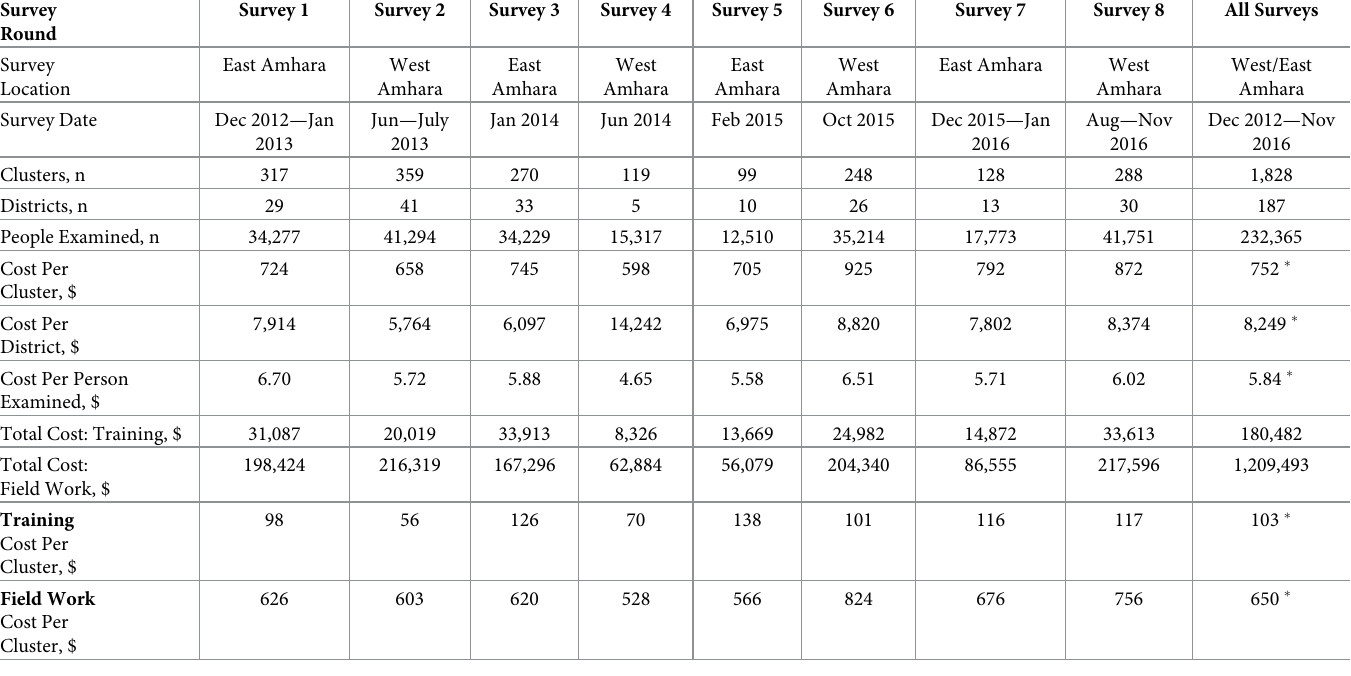
Table 2. Trachoma impact and surveillance surveys costs, Amhara, Ethiopia,